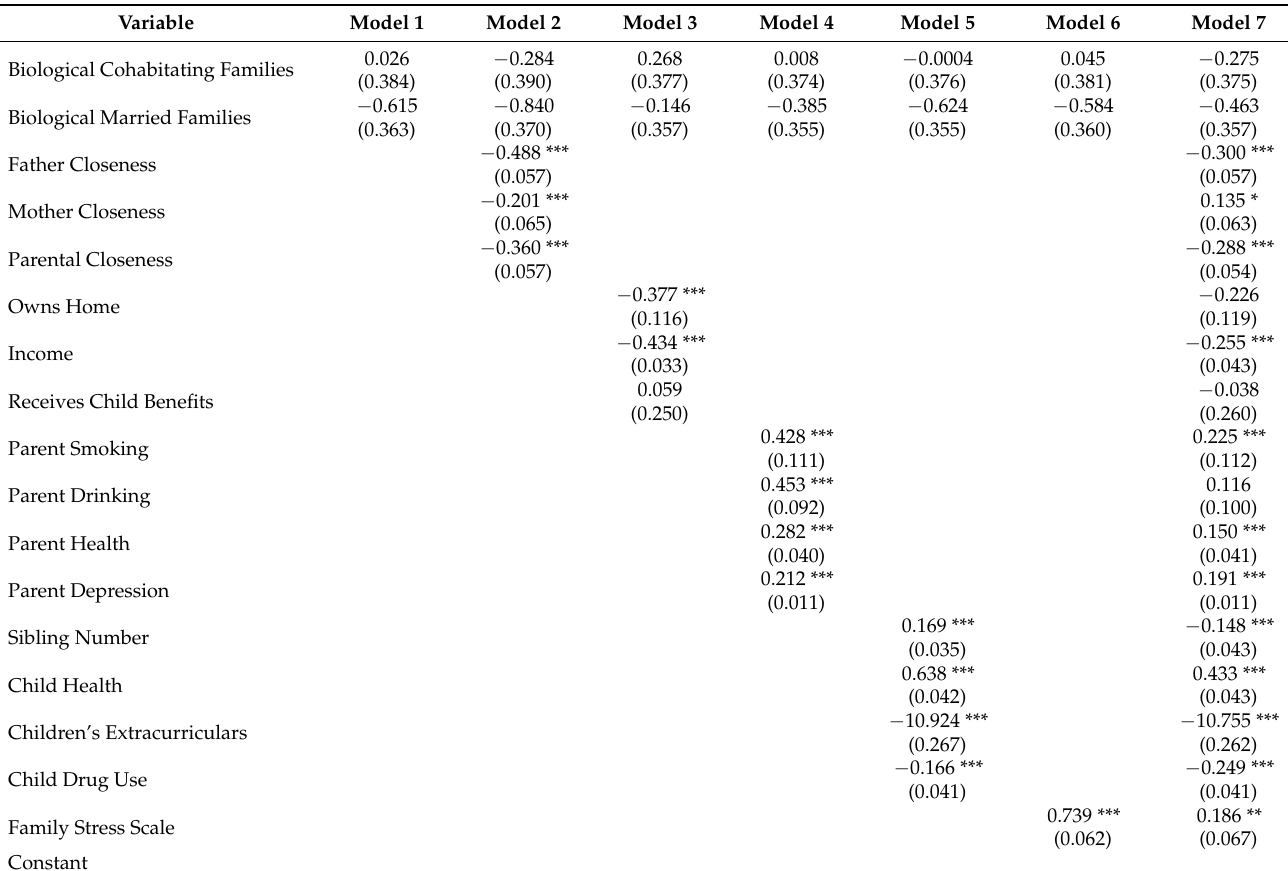
Table 3. Ordinary Least Squares Regression of Internalizing Behavior on Family Structure (Model 1), Parental Closeness, (Model 2) Financial Resources (Model 3), Parental Health (Model 4), Child Health (Model 5), Family Stress (Model 6) and Full Model (Model 7). Stepmother families are the reference